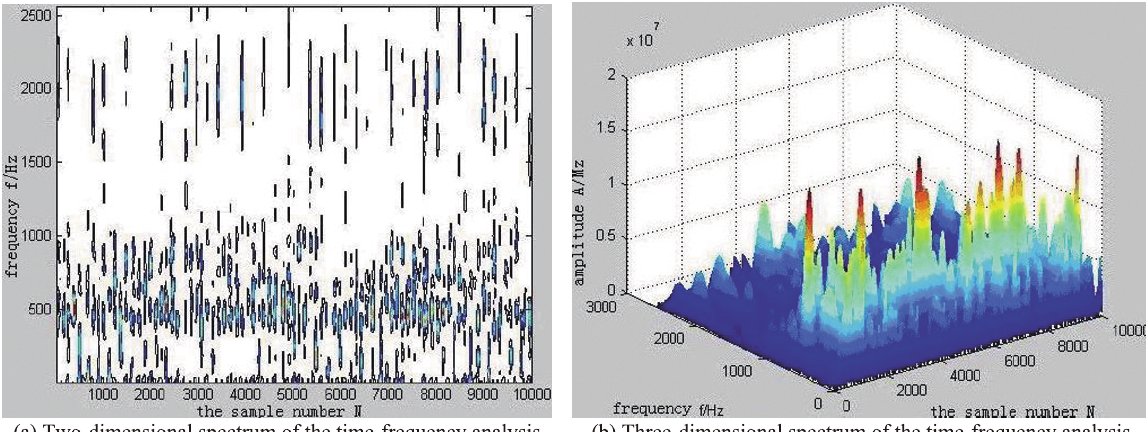
Fig. 12. The time frequency analysis of a tooth wear signal at 900